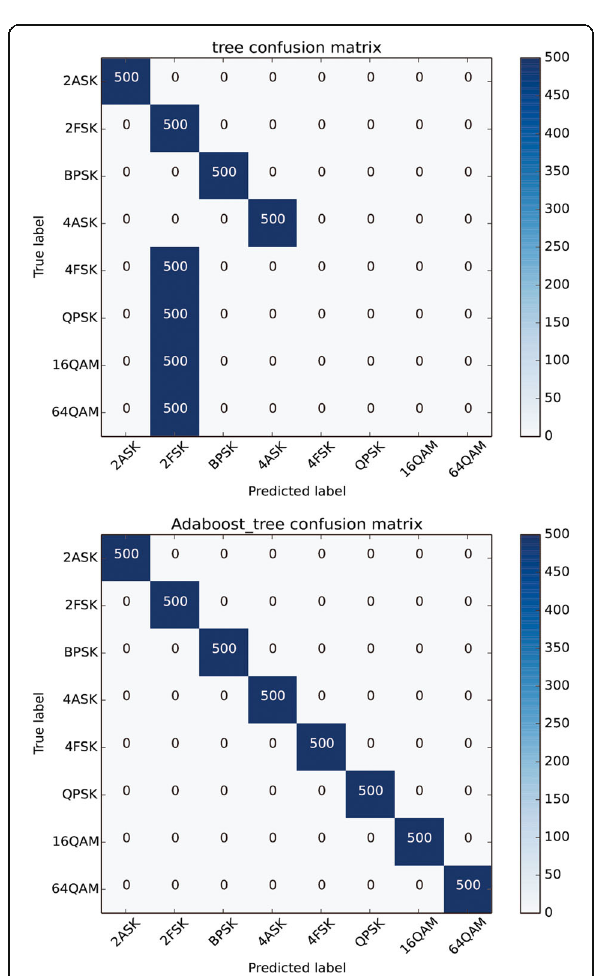
Fig. 4 Recognition confusion matrix of DT and AdaBoost versus SNR = 5 dB, tree depth is